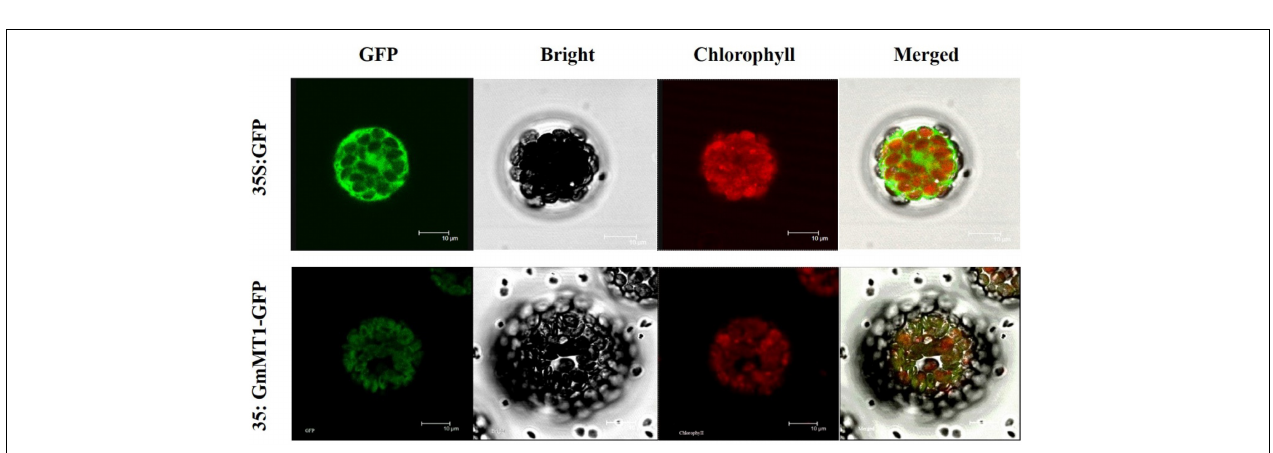
FIGURE 3 | The expression patterns of GmMT1 in soybeans. (A) Relative expression of GmMT1 in the seeds of the high-isoflavone cultivar “Zhongdou27” and low-isoflavone cultivar “Dongnong8004” during development. Seeds were sampled every 7 days from the start of stage R5 to the end of stage R8. (B,C) Expression of GmMT1 in soybean leaves in response to panels (B) salt and (C) drought stress. Time represents the hours after stress initiation. n = 3 samples per stage or time point. “ ∗∗ ” and “ ∗ ” indicate P < 0.01 and P < 0.05 based on Student’s two-tailed t- test.